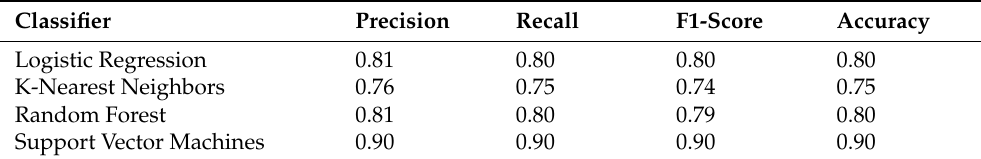
Table 2. Classification